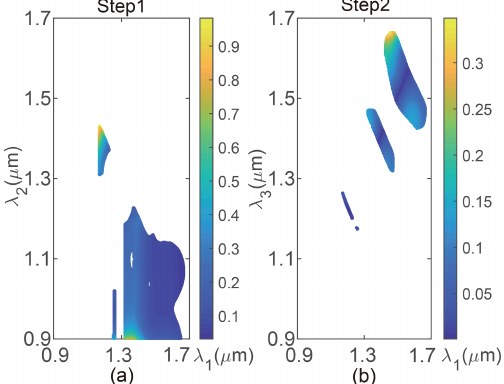
Figure 8. (a) Values of parameter p step1 as a function of λ 1 and λ 2 . (b) Values of parameter p step2 as a function of λ 1 and λ 3 .